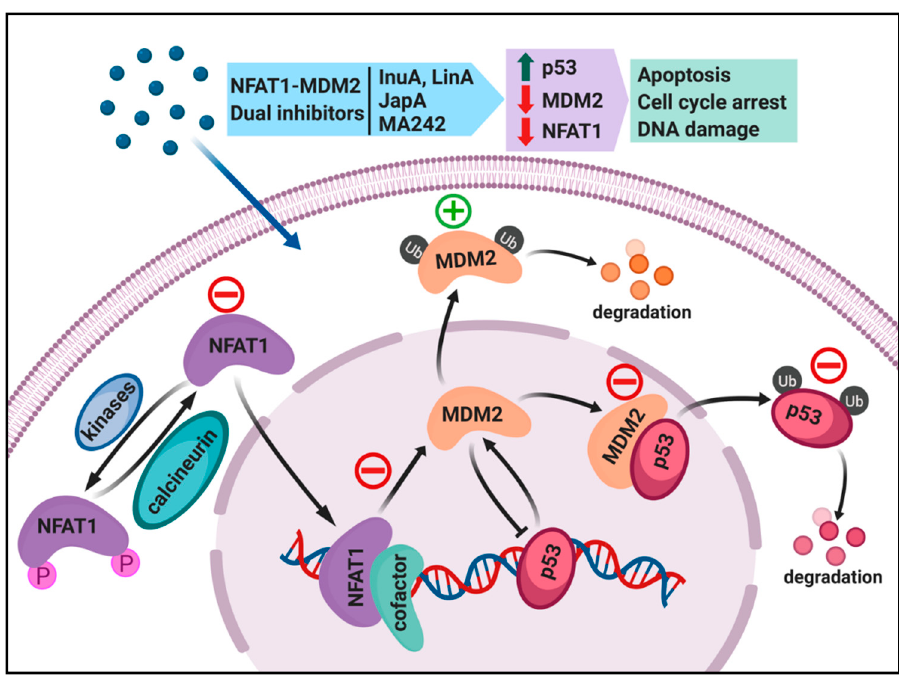
Figure 1. Targeting the NFAT1-MDM2-P53 pathway for cancer therapy. Different classes of NFAT1-MDM2 dual inhibitors can affect different components of this pathway. Lineariifolianoid A (LinA) and Inulanolide A (InuA) inhibit cancer cells by dual inhibition of NFAT1 and MDM2. Japonicone A (JapA) suppresses cancer cells by binding directly to the p53-binding domain of MDM2 and promoting MDM2 auto-ubiquitination, and also through the inhibition of NFAT1-mediated MDM2 transcription and induction of NFAT1 degradation. MA242 induces MDM2 self-ubiquitination and represses NFAT1-mediated transcription of MDM2. The red minus and green symbol indicate inhibition or stimulation induced by NFAT-MDM2 inhibitors.